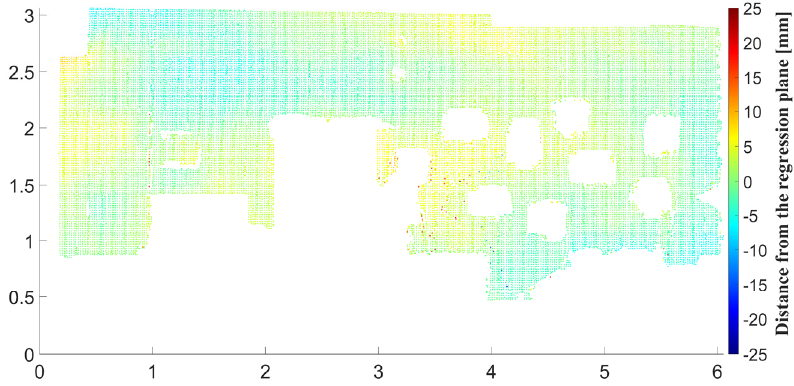
Figure 13. Deviation map—quantification of flatness of the wall.